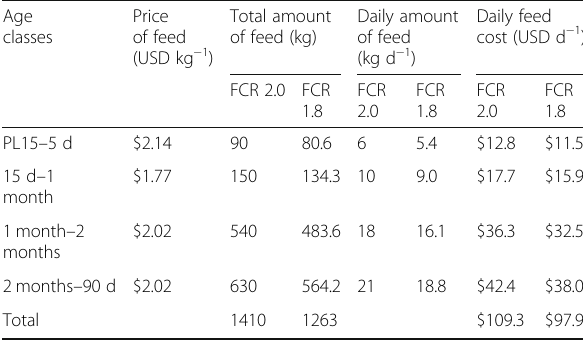
Table 4 Feed inputs and cost calculation based on FCRs of